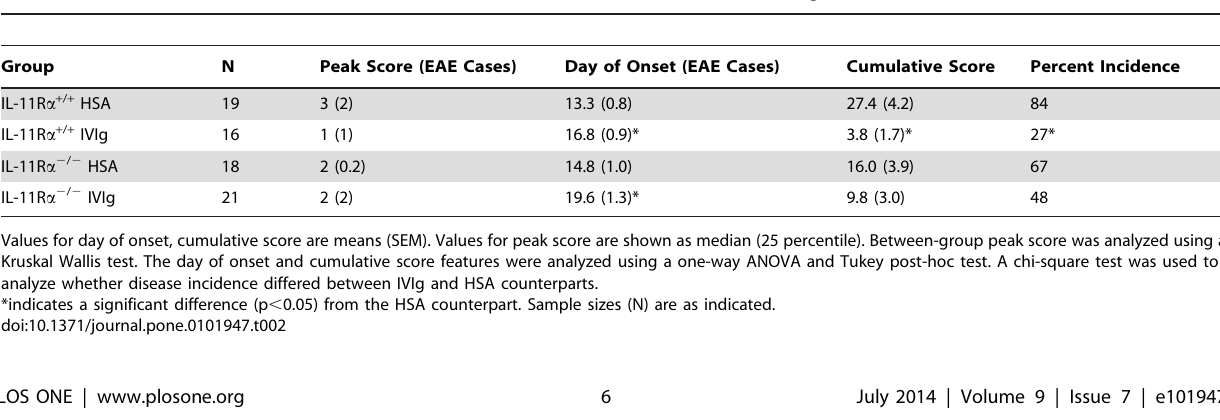
Table 2. Clinical Features of EAE in IL-11R a + / + and IL-11R a 2 / 2 mice treated with IVIg or HSA.